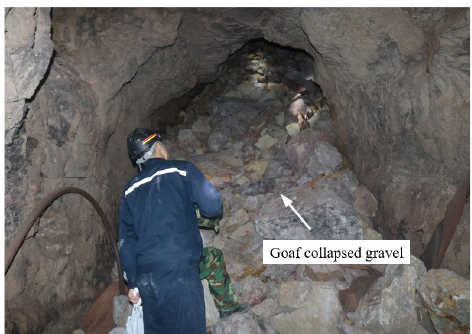
Figure 15. Collapse of goaf.